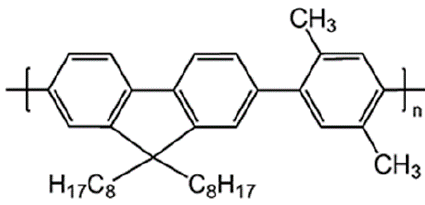
Figure 1. Molecular structure of conjugated polymer PFO-co-pX (ADS145UV).